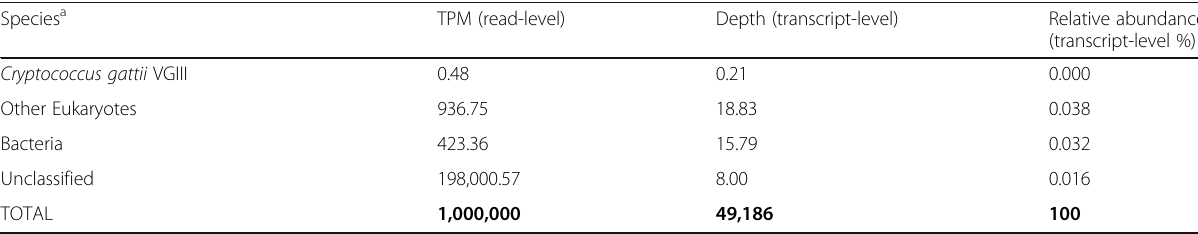
Table 2 Abundance of reads (TPM) and abundance of transcripts (Depth) per fungal species detected with metatranscriptomics. True members of the mock community – at species level – are shown in bold (Continued)